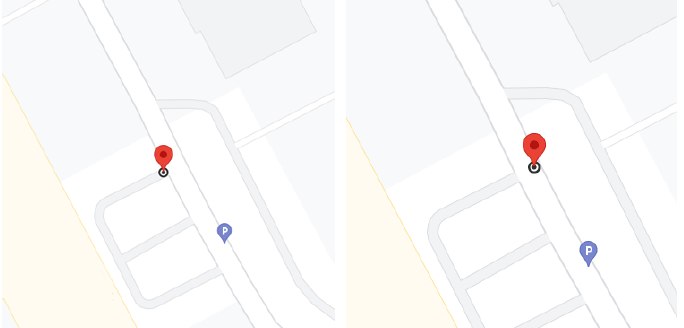
Figure 9. The estimation position of the pedestrian ( left ). The real position of the pedestrian ( right